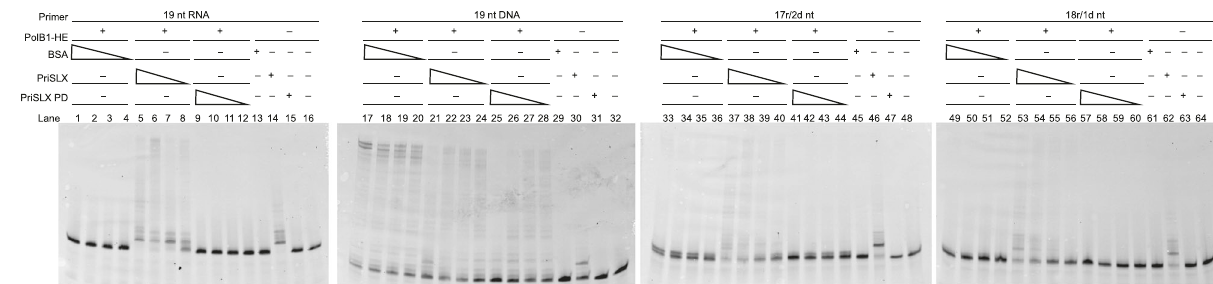
Fig. 3 Primer elongation by sub-saturating amounts of PolB1-HE. Primer elongation reactions of 100 µ M dNTPs; 25 nM 5 ′ -cy5-labeled primer as indicated annealed to 80 nt template; 6 nM PolB1-HE as indicated; BSA titration (200, 100, 50, 25 nM) and control (200 nM) as indicated; PriSLX titration (200, 100, 50, 25 nM) and control (200 nM) as indicated; and PriSLX PD (Polymerase Dead) titration (200, 100, 50, 25 nM) and control (200 nM) as indicated. Reactions were incubated for 5 min at 75 °C prior to termination and electrophoresis on denaturing polyacrylamide gels. Three independent replicates of this experiment